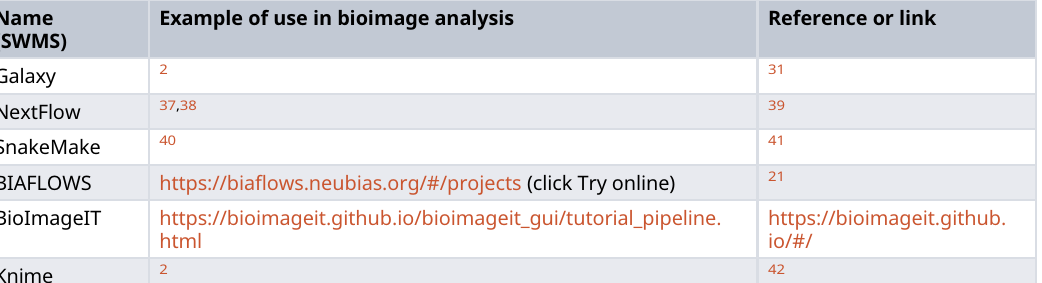
Table 3. Some example of scientific workflow management